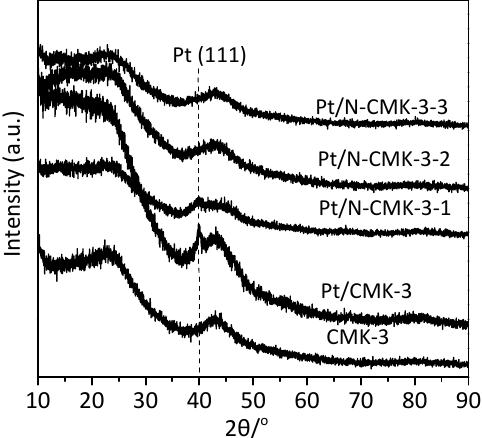
Figure 2. XRD patterns of the CMK-3, Pt/CMK-3, and Pt/N-CMK-3-x (x = 1, 2, and 3) samples.